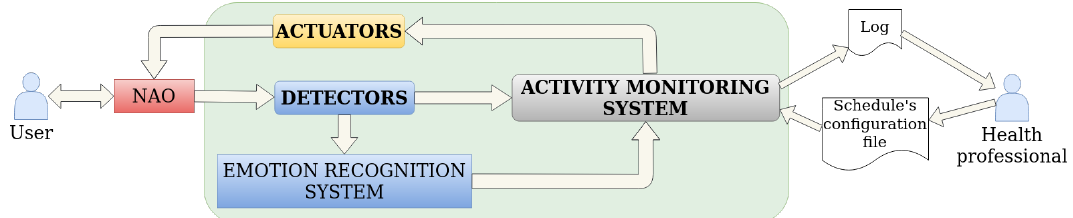
Figure 1. SARDAM’s